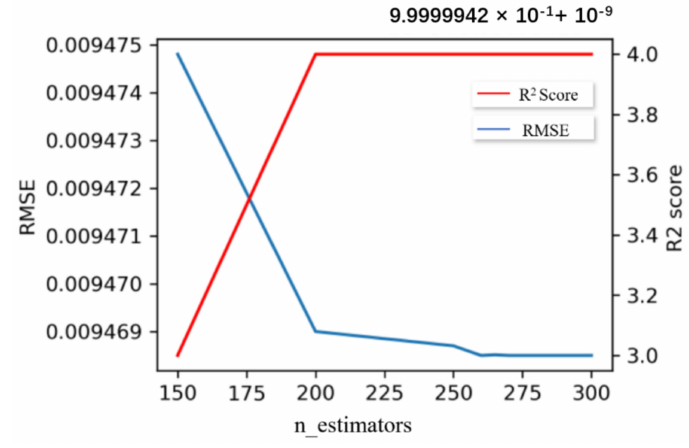
Figure 1. n_estimators adjustment diagram.